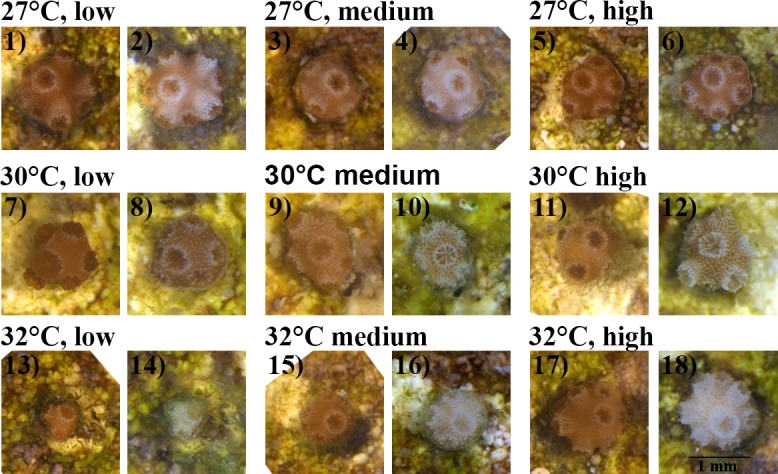
Images of juveniles on day 39 (odd numbers) and 59 (even numbers) of treatment exposure.Treatments consisted in three levels of nutrient enrichment (low, medium and high) and three temperatures (27, 30 and 32°C). Control treatment: ‘low’ nutrient enrichment and at temperature = 27°C.